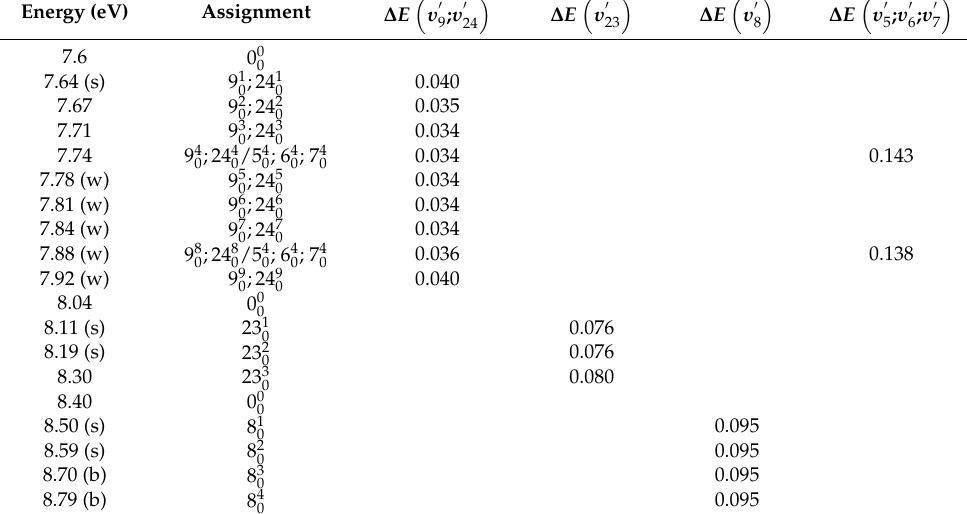
Table 6. Proposed vibrational assignments in the 7.3 − 9.0 eV absorption band of 2BrPyr (Band V). ∆ E (in eV) represents the energy of one extra quanta in the vibrational progression. The symbol “/” means both modes are involved; the symbol “;” means two alternative